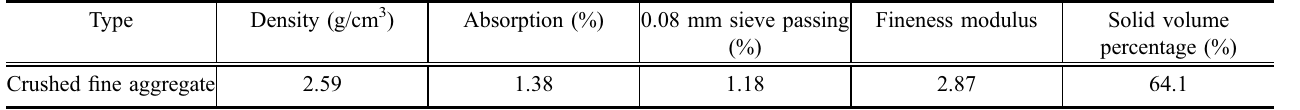
Table 3 Properties of fine aggregate.